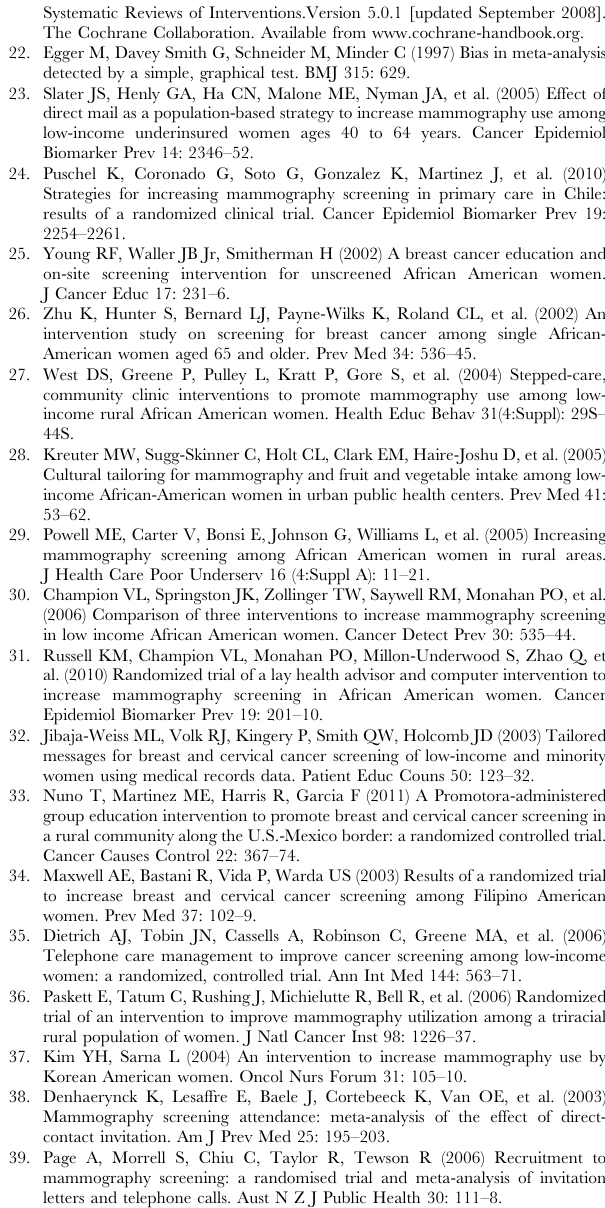
Table S1 Search strategy used to search Medline